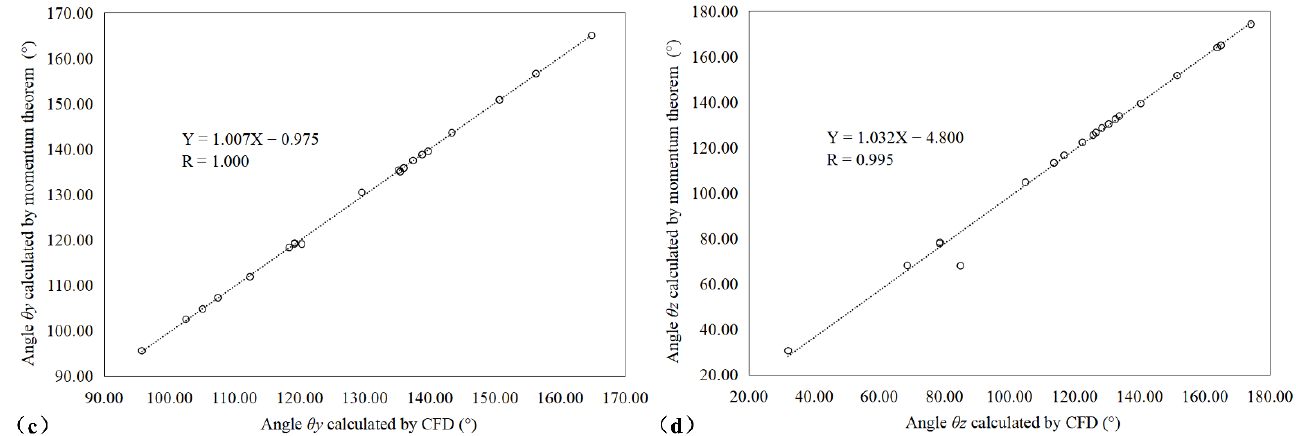
Figure 4. Linear scatter diagram showing the correlation between the magnitude of ( a ) displacement